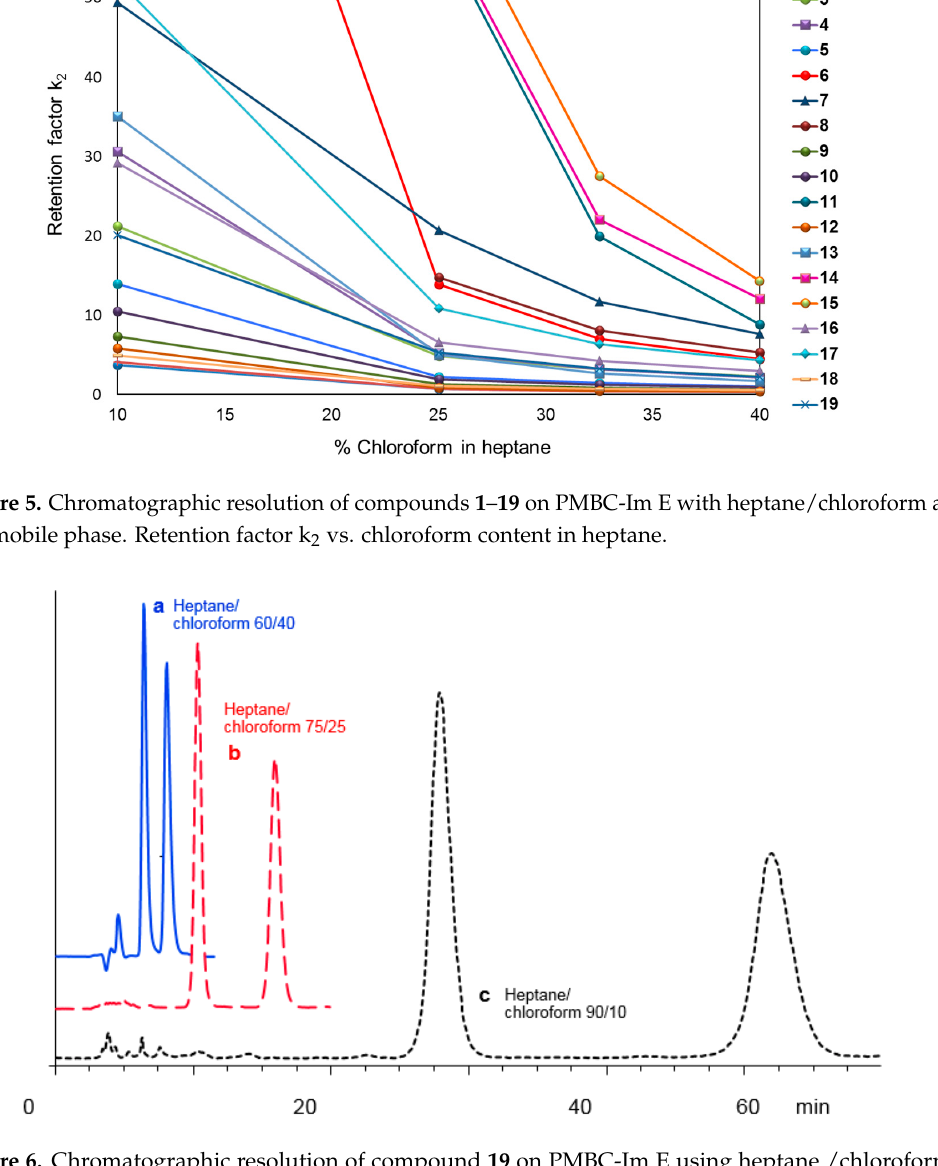
Figure 6. Chromatographic resolution of compound 19 on PMBC-Im E using heptane /chloroform mixtures as a mobile phase: ( a ) 60/40 ( v/v ); ( b ) ----- 75/25 ( v/v ); and ( c ) …… 90/10 ( v/v ).